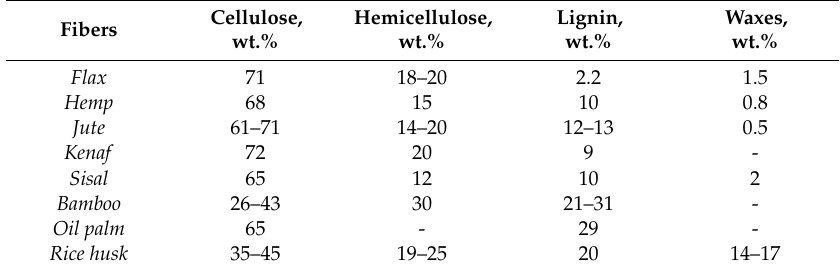
Table 7. Basic chemical composition of some common natural fibers [71], Reproduced with permission from Faruk O, Progr. Polym. Sci.; published by Elsevier, 2012 . Cellulose, Fibers